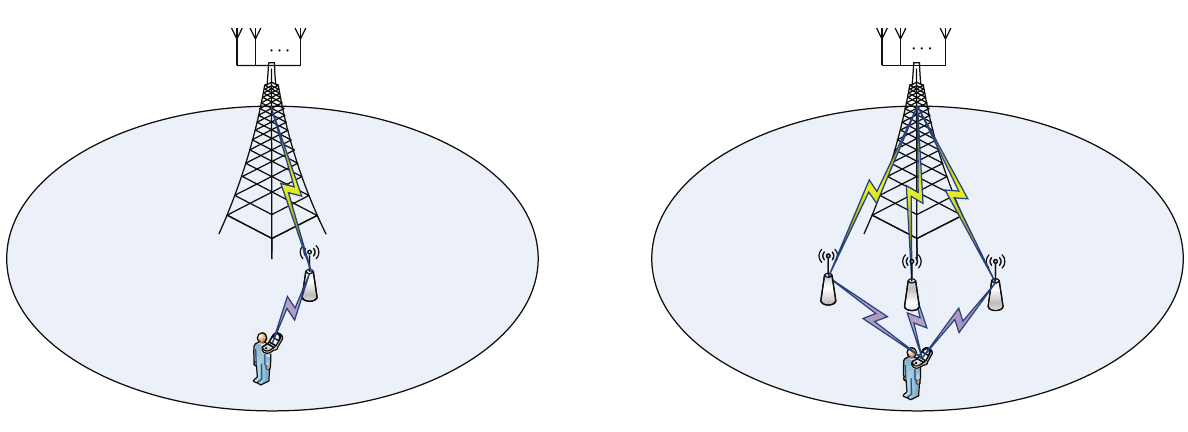
Figure 2: Single-relay communication. Figure 3: Multiple-relay